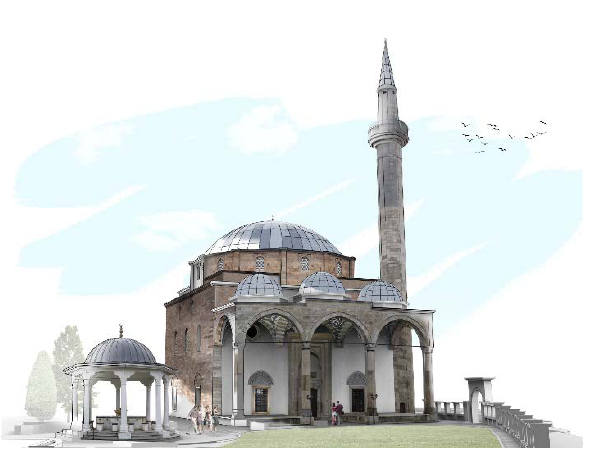
Figure 12. Final render of the